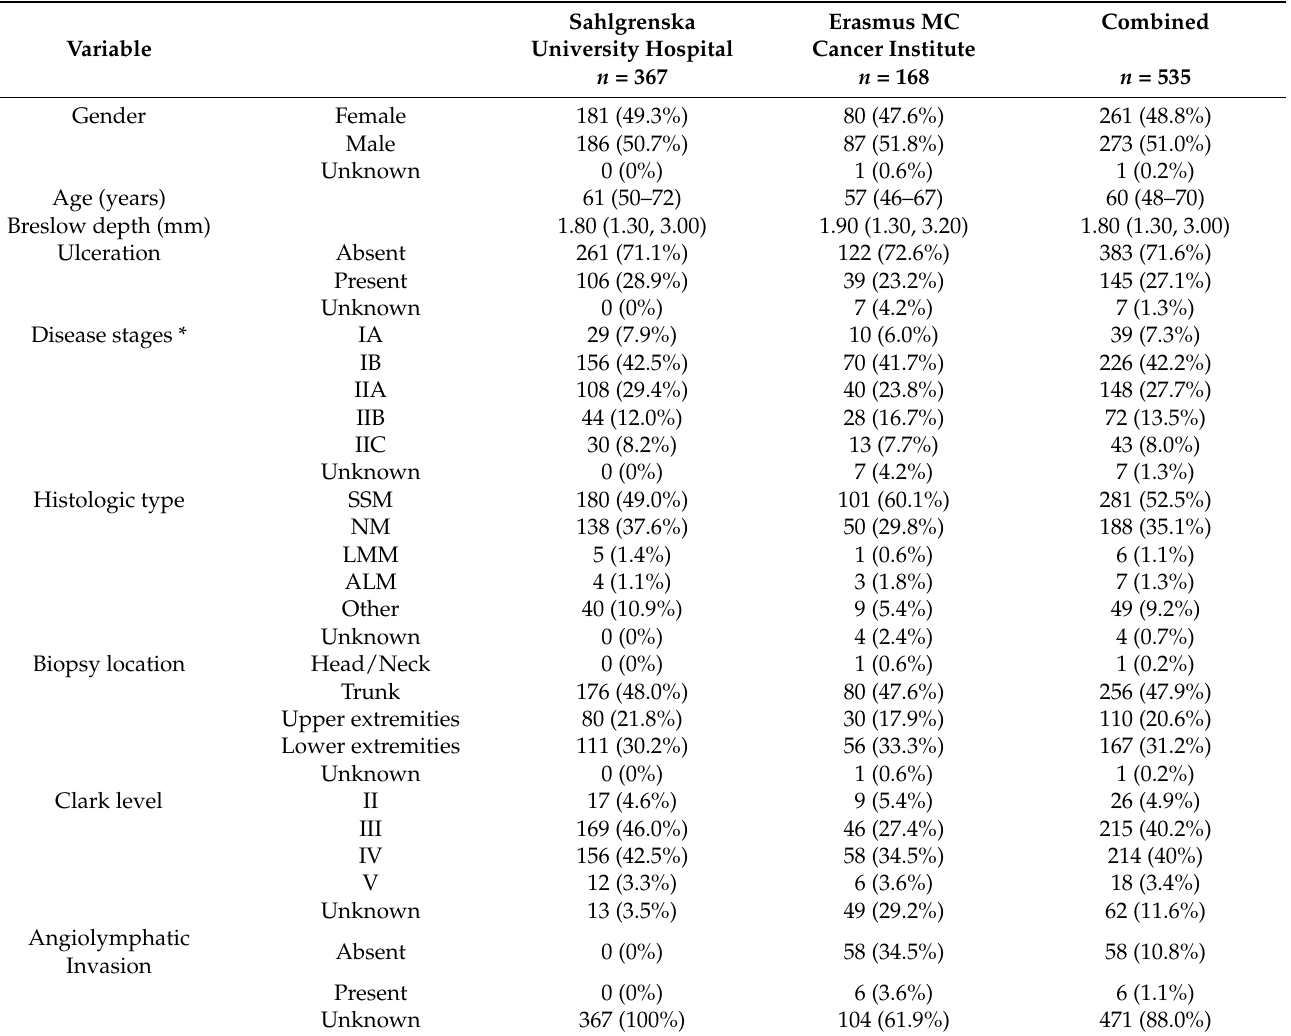
Table 1. Baseline characteristics of patients with stage I–II melanoma. n (%) or median (interquartile range). ALM, acral lentiginous melanoma; LMM, lentigo maligna melanoma; NM, nodular melanoma; SLNB, sentinel lymph node biopsy; SSM, superficial spreading melanoma. * According to AJCC